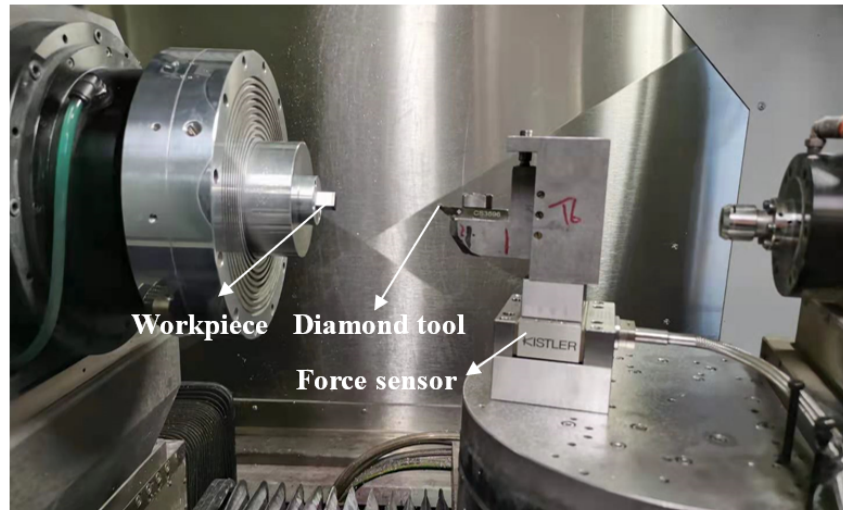
Figure 10. Photo of the machining setup for the low-frequency UVAC.